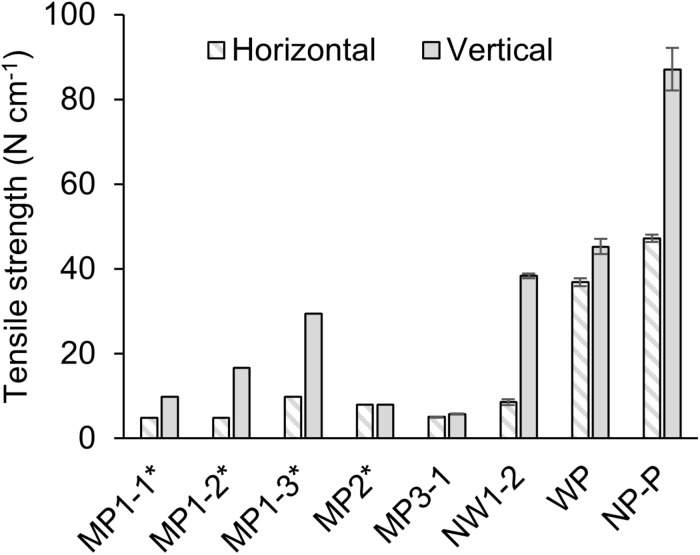
Tensile strength of the films. The error bar shows the standard deviation of N = 3. The values with asterisks (*) were derived from the product datasheet. MP: microporous; WP: woven porous; NW: microporous with a non-woven fabric; and NP-P: non-porous polypropylene film.